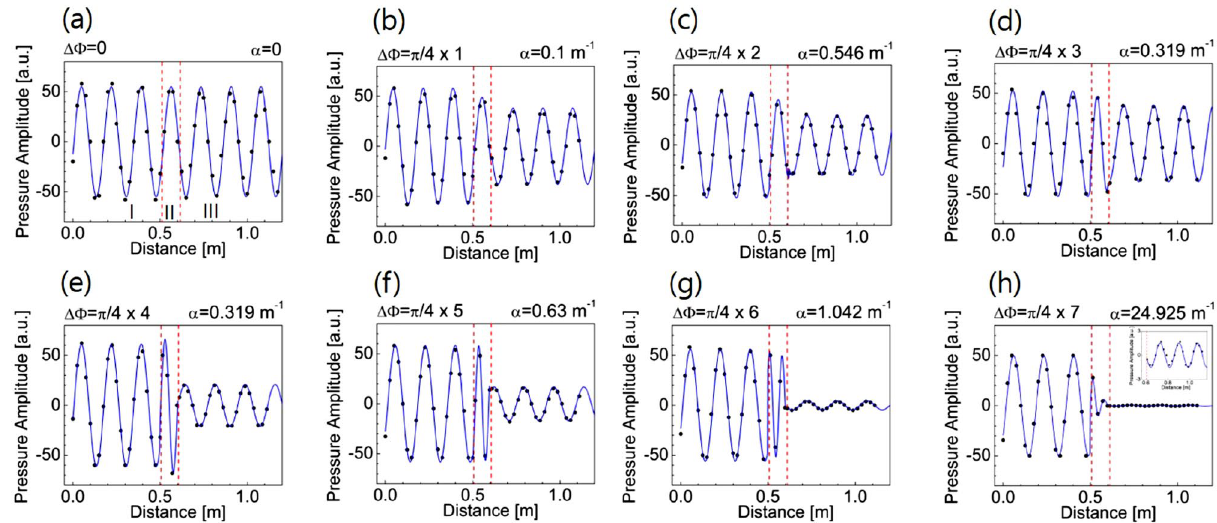
Figure 3. Sound propagation through the unit-cell groups with the same phase change of π/ 4 between the unit-cell groups adjacent to each other at the reference frequency. Black dots represent the measured values from the experiment, and the blue solid lines indicate their numerical fit results. In each graph, a unit-cell group consisting of four 1D FCOC unit cells with the same orifice diameter is located between the normal waveguides (in the red dotted line). The inset in figure ( h ) shows a 3 × image of the transmitted sound amplitude.